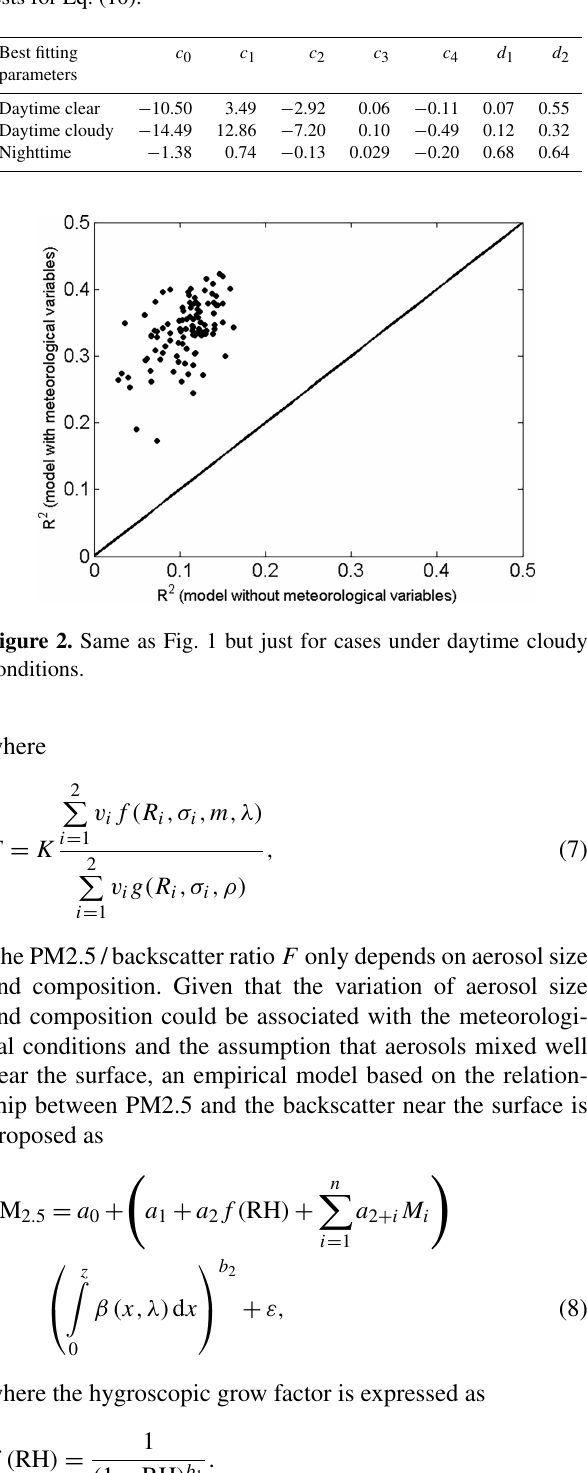
Table 2. Parameters based on the best fitting of 100 independent tests for Eq. (10).